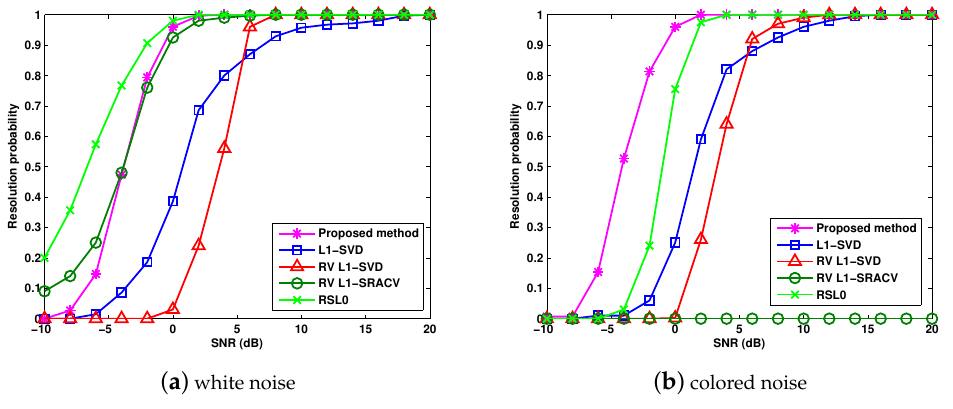
Figure 7. RMSE versus target resolution